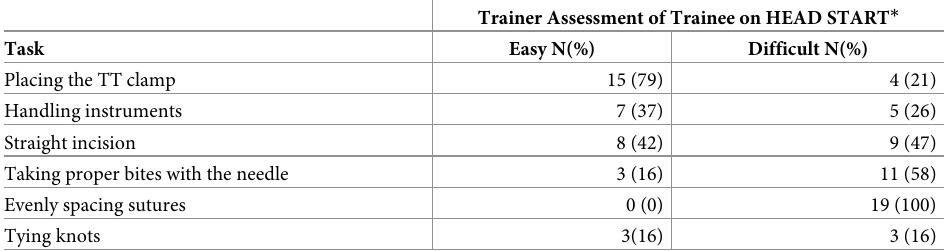
Table 2. Trainer Assessment of Trainees on HEAD START at Start of Training Session.